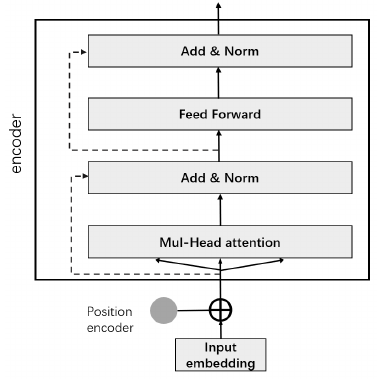
Figure 9. Structure diagram of Transformer.